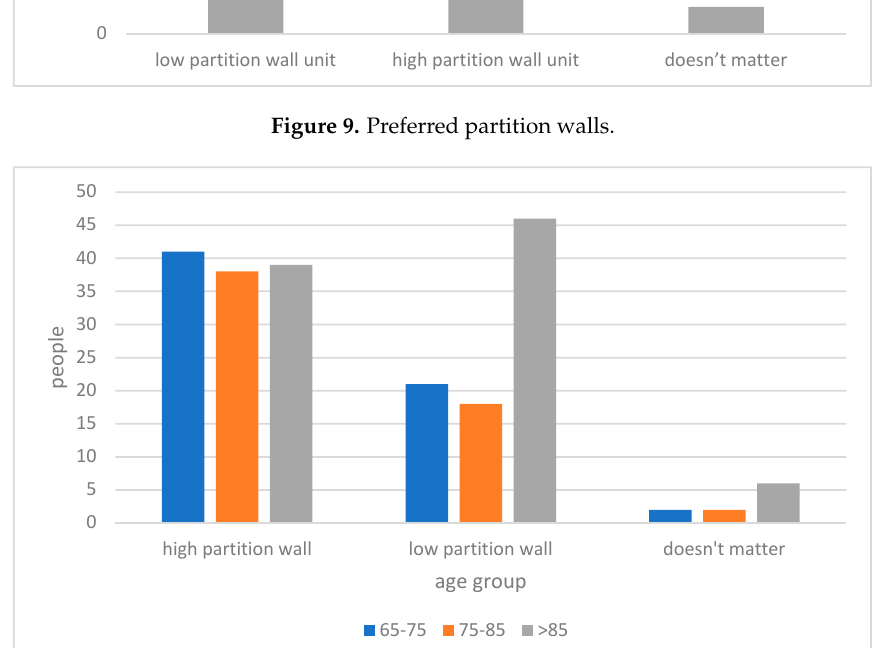
Figure 10. Preferred partition walls with age group.